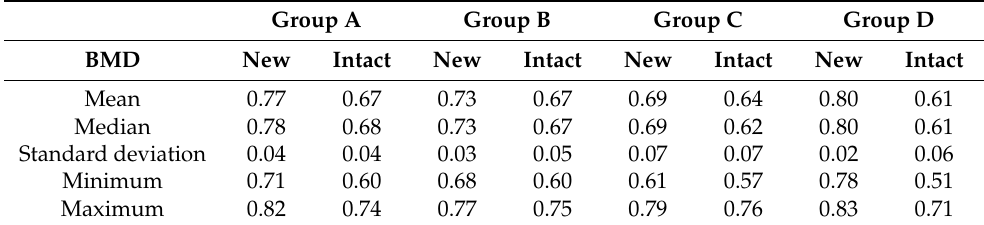
Table 2. Bone mineral density (g/cm 3 )—descriptive